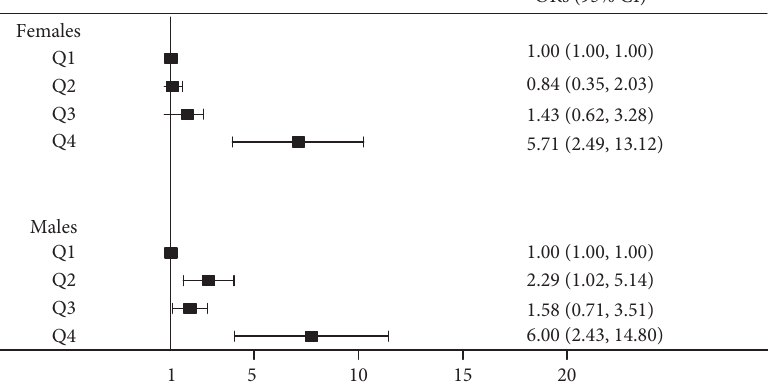
Figure 3: Odds ratios (ORs) and 95% con fi dence intervals (CI) for Acanthosis nigricans , according to serum UA quartiles: results of logistic regression. The ORs (95% CI) for AN in the highest serum UA quartile (Q4) was signi fi cantly higher compared to the lowest quartile of serum UA (Q1) for both sexes.